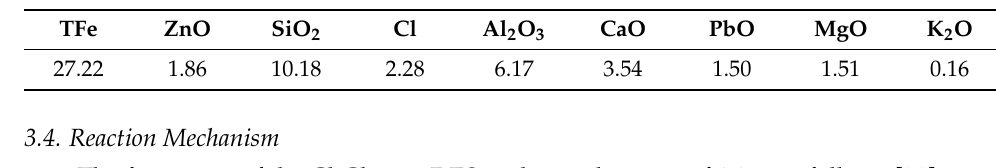
Figure 9. Molecular structure diagram of the reaction product between ZnO and the ChCl-urea DES. 3.5. Leaching Kinetic Analysis To determine the mechanism of the leaching reaction and maximize the efficiency of the leaching process, the reaction kinetics was modeled. The reaction of ZnO with the ChCl-urea DES is a heterogeneous (solid–liquid reaction), and the reactants (powder par- ticles) were regarded as uniform spheres; hence, the most used type of model for such systems, the nuclear shrinkage model, was adopted. During the leaching process, the free urea reacts with Cl – and zinc oxide in the zinc-bearing dust sludge, and the product [ZnOCl(NH 2 CONH 2 ) 2 ] − dissolved in the leaching agent. Therefore, the leaching process is produced without a solid product layer reaction. Due to the high concentration of ChCl- urea DES, the consumption of urea and Cl − during the reaction can be ignored, and the concentration of the extractant can be regarded as unchanged. Therefore, the integrated rate equation is shown below [22]: